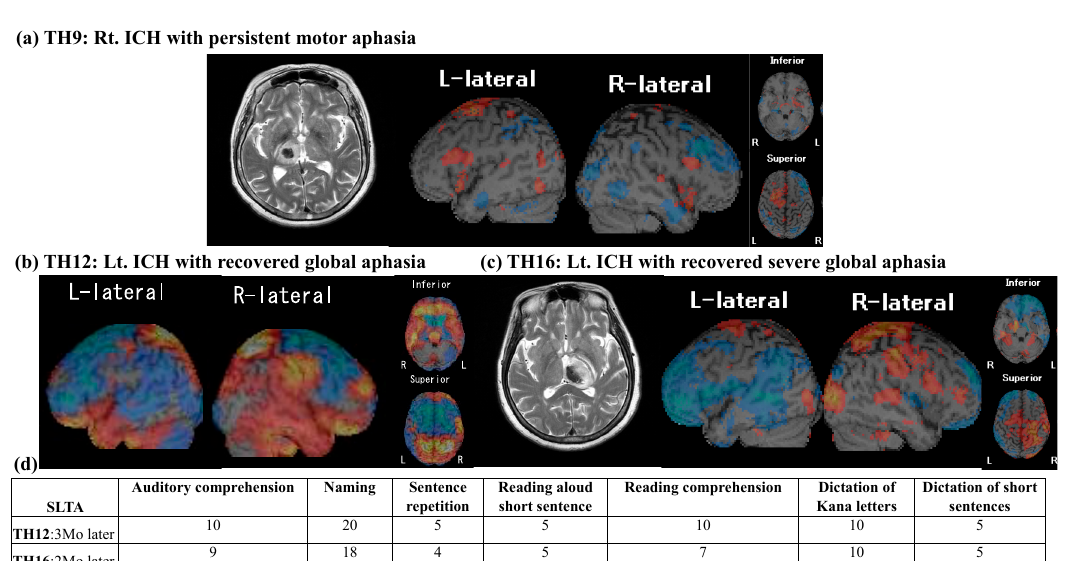
Figure 2. Initial SPECT results of patients with aphasia. ( a ) Axial view of T 2 -weighted MRI imaging and SPECT Z-map (from patient TH9). TH9 su ff ered from motor dysphasia due to right thalamic hemorrhage, and the dysphasia persisted for one year. L: left; R: right. ( b , c ) Axial view of T 2 -weighted MRI imaging and SPECT Z-maps (from patients TH12 and TH16). ( d ) Follow-up SLTA. Both patients su ff ered from global aphasia after left thalamic hemorrhage, but they recovered from aphasia within a few months after onset. Mo: